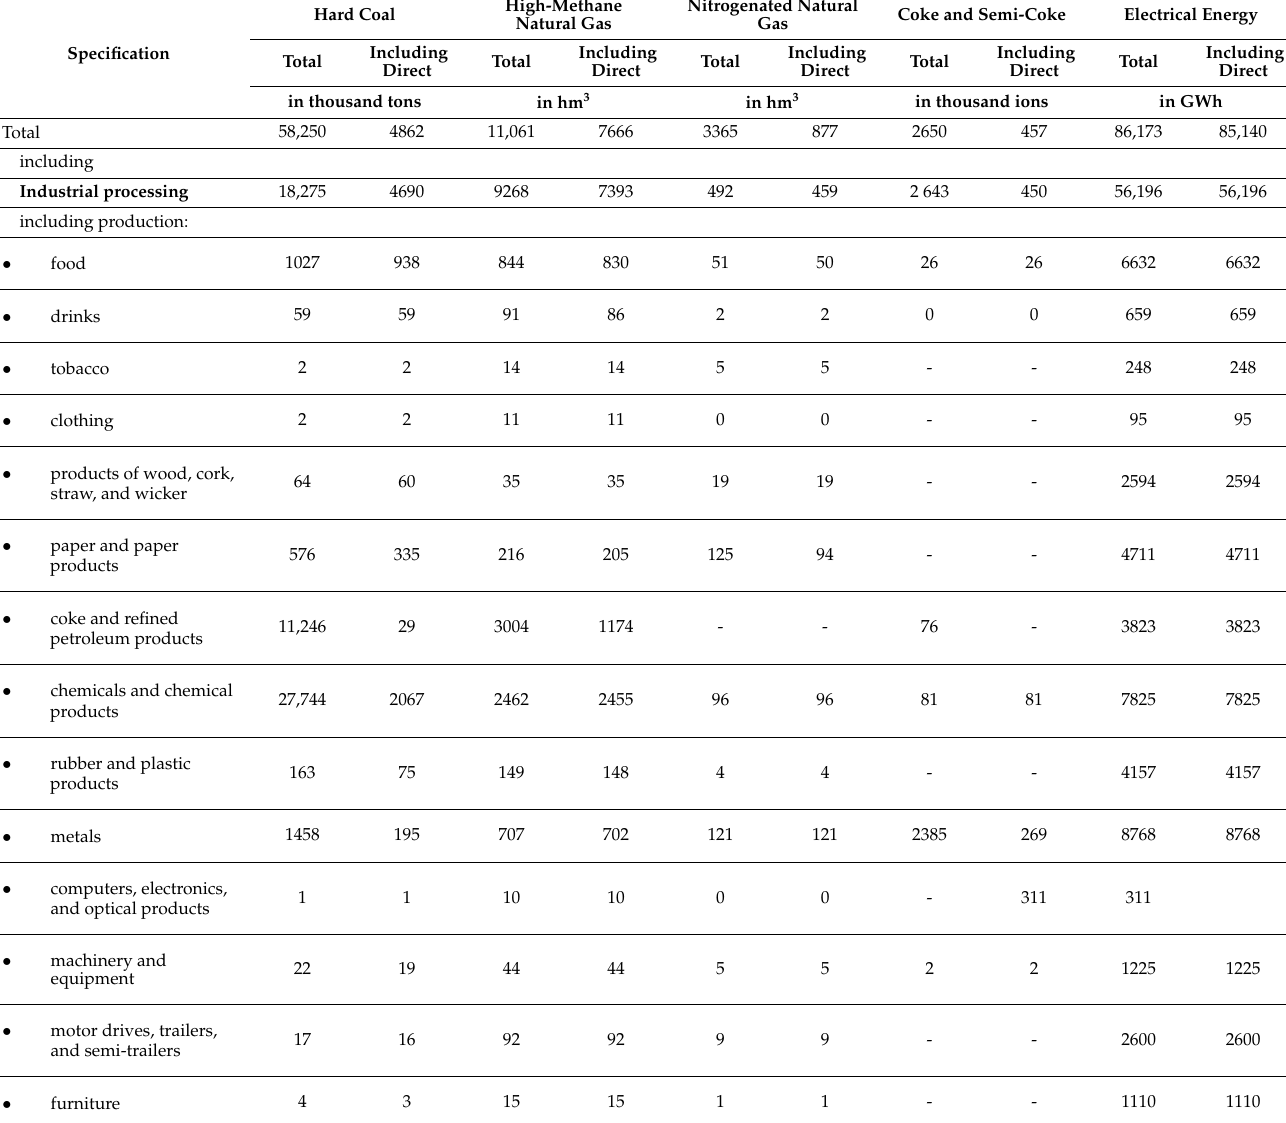
Table 3. Consumption of certain fuels and electricity in industry by selected sections in